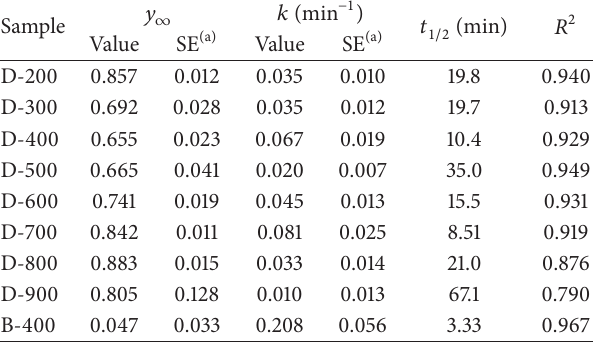
Table 2: Parameters of the pseudo-first-order kinetic model for the degradation of fenchlorphos.